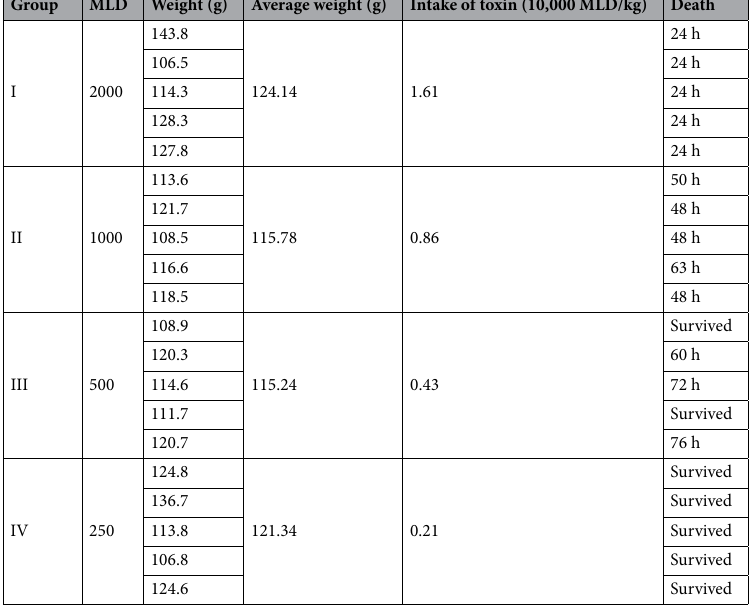
Table 3. Oral lethality test of different toxic mineralized toxin particles on plateau pika.